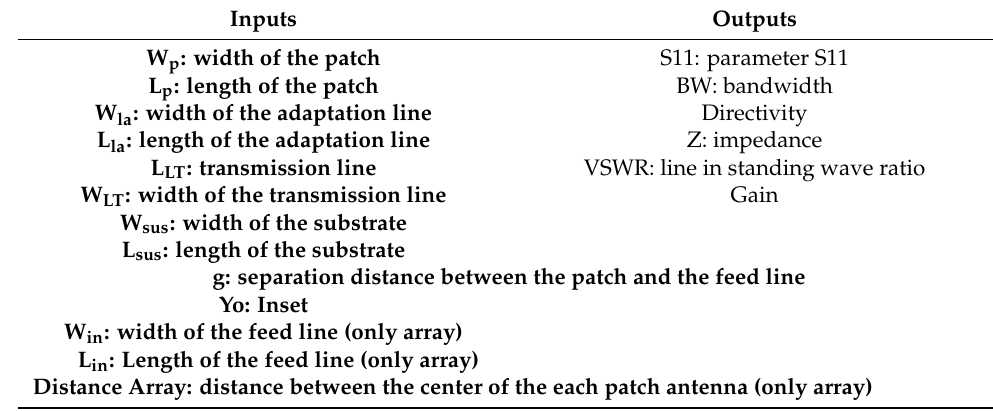
Table 8. Input and output parameters of the